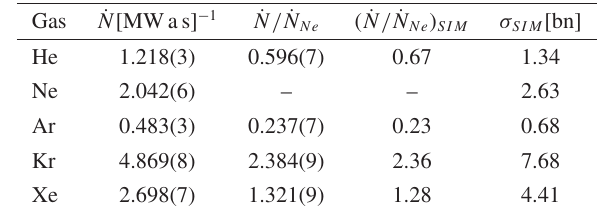
Table 1. Measured count rate per gas atom normalized by beam power is given in the second column. Values relative to Ne data are given in the third and fourth columns for experimental and simulated data, respectively. Errors are statistical only, and do not include variation in pressure and temperature during runs. Simulated data does not yet include effects from interatomic pair potential which may affect the results at the 1%